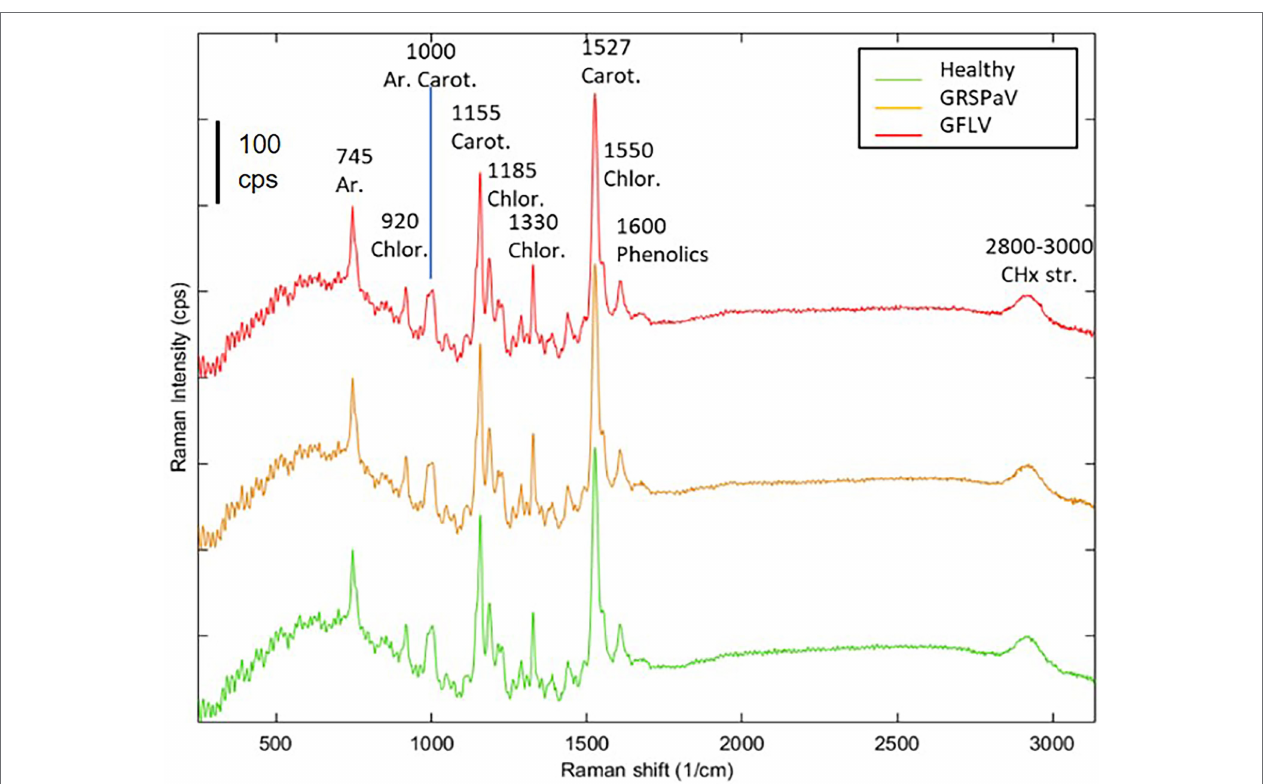
FIGURE 2 | Average Raman spectra of healthy (green), GRSPaV- (yellow), and GFLV- (red)-infected grapevine cv. Chardonnay leaves. Spectra are the result of four plants per group. Representative spectra collected in the first measurement session (T1) are shown.